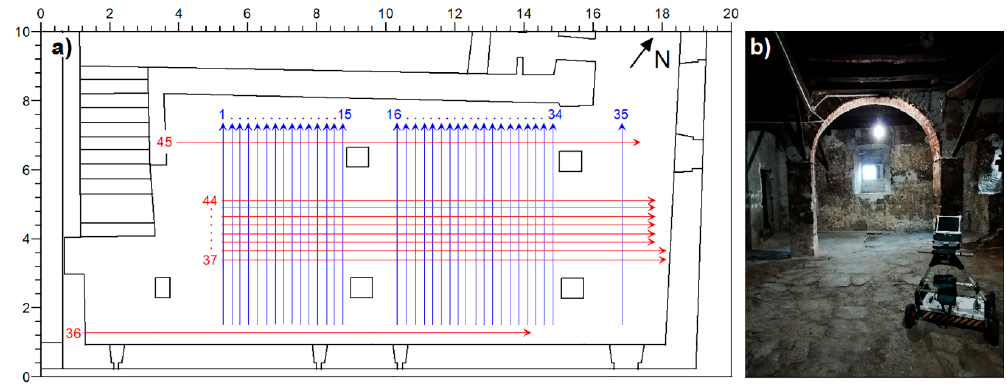
Figure 3. Survey plan showing profiles position ( a ) and IDS Georadar during data acquisition ( b ).